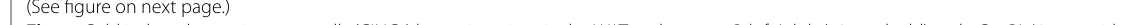
Fig. 4 Cold induced neuroimmune cells (CINCs) home in to inguinal scWAT and express Bdnf . Adult (12 week old) male C57BL/6 were either maintained at room temperature (RT) or cold exposed (5 °C) for 5 days, ATMs from inguinal scWAT depots were isolated using magnetic‑activated cell sorting (MACS) by positive selection of CD11b + followed by F4/80 + cells. Bdnf gene expression in doubly labeled CD11b + F4/80 + macrophages was compared between RT and cold exposed animals, p 0.5796 ( a ). Data were analyzed by two‑tailed Student’s T ‑Test, N 4 per group. Adult = = (12 week old) female control animals were either maintained at room temperature (RT) or cold exposed (5 °C) for 10 days, SVF from bilateral inguinal scWAT was isolated and FACS sorted using a 20 cell surface marker panel for myeloid lineage immune cells ( b , c ). Changes in M1/M2 polarity, RT versus cold M1 macrophages p 0.8485 , and RT versus cold M2 p 0.3387 ( b ) and Ly6C + CCR2 + Cx3CR1 − and Ly6C + CCR2 + Cx3CR1 + macrophage = = precursors/monocytes ( c , left panel) were measured between RT and cold exposed animals, p 0.0401 and p 0.0354, respectively. Adult = = (12–13 week old) male C57BL/6 were either maintained at room temperature (RT) or cold exposed (5 °C) for 14 days; SVF from bilateral inguinal scWAT was isolated and FACS sorted; Ly6C + CCR2 + Cx3CR1 − and Ly6C + CCR2 + Cx3CR1 + cells were compared between RT and cold exposed animals, p 0.9525 and p 0.0566 , respectively ( c , right panel). Data were analyzed by two‑tailed Student’s T ‑Test, N 3–4 per group for both sexes. Adult = = = male (M) and female (F) control animals were either maintained at room temperature (RT) or cold exposed (5 °C) for 10 days, SVF from bilateral inguinal scWAT was isolated and FACS sorted using a 20 cell surface marker panel for myeloid lineage immune cells (N 5 per group). t‑Distributed = Stochastic Neighbor Embedding (tSNE) analysis was performed to identify myeloid lineage cell population changes in response to cold exposure; Ly6C + CCR2 + Cx3CR1 + were identified for both sexes as adipose CINCs ( d ). Bdnf gene expression measured in Ly6C + CCR2 + Cx3CR1 + cells indicated that these infiltrating cells express Bdnf, p 0.1529 ( e ). Data analyzed by two‑tailed Student’s T ‑Test, N 4 per group. For all error bars are SEMs. = = *p < 0.05, **p < 0.01, ***p < 0.001, ****p